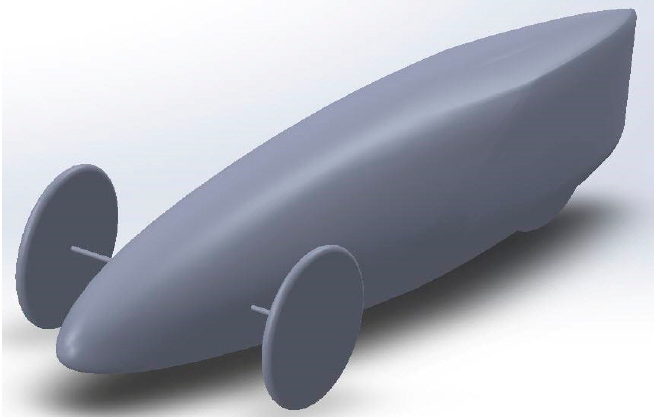
Figure 5. Car design with the front tires outside.